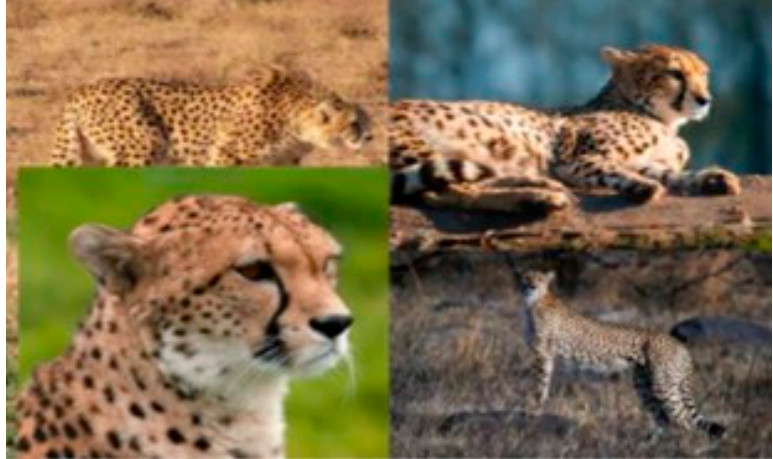
Figure 16. Images of different poses [57].